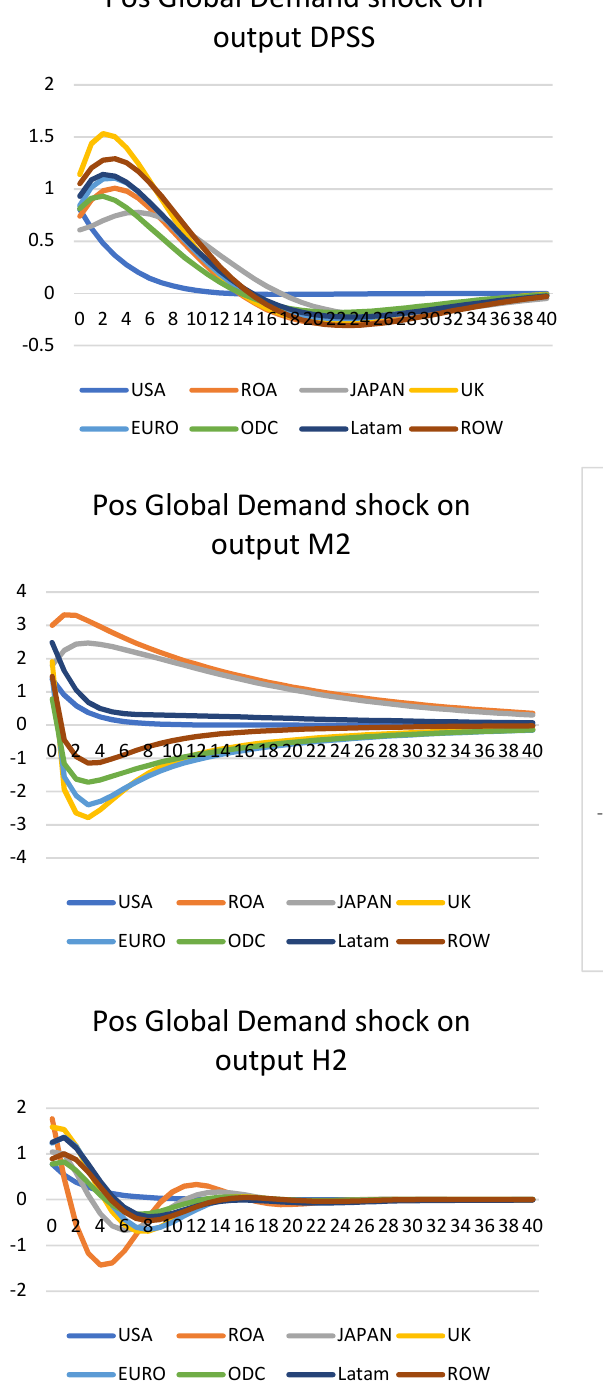
Figure 5. Positive global demand shock on output. Supply shock on output—Figure 6